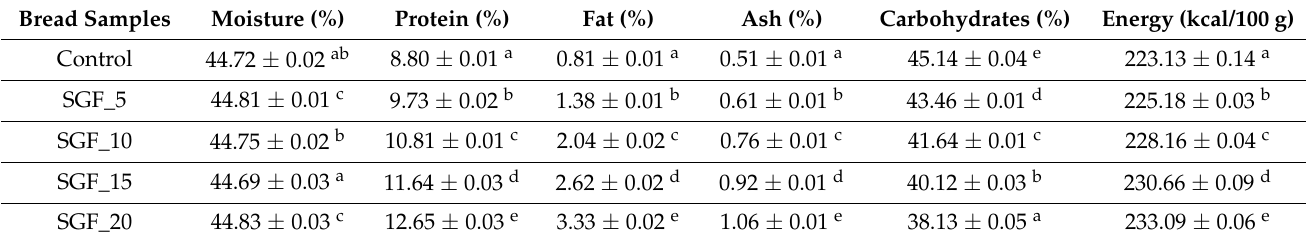
Table 7. Compositional analysis of bread samples with different levels of germinated soybean flour (SGF).